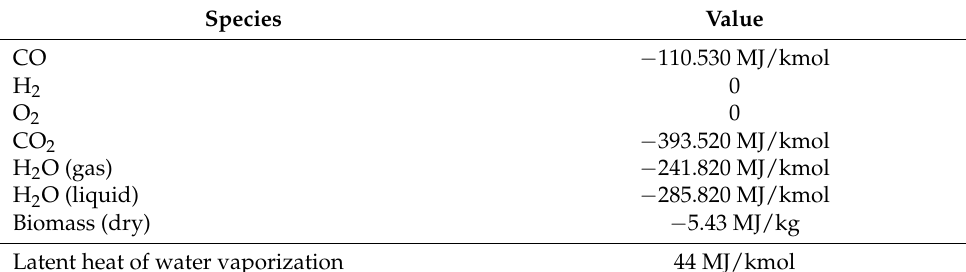
Table 3. Heats of formation of substances and latent heat of water vaporization. Species Value CO − 110.530 MJ/kmol H 2 0 O 2 0 CO 2 − 393.520 MJ/kmol H 2 O (gas) − 241.820 MJ/kmol H 2 O (liquid) − 285.820 MJ/kmol Biomass (dry) − 5.43 MJ/kg Latent heat of water vaporization 44